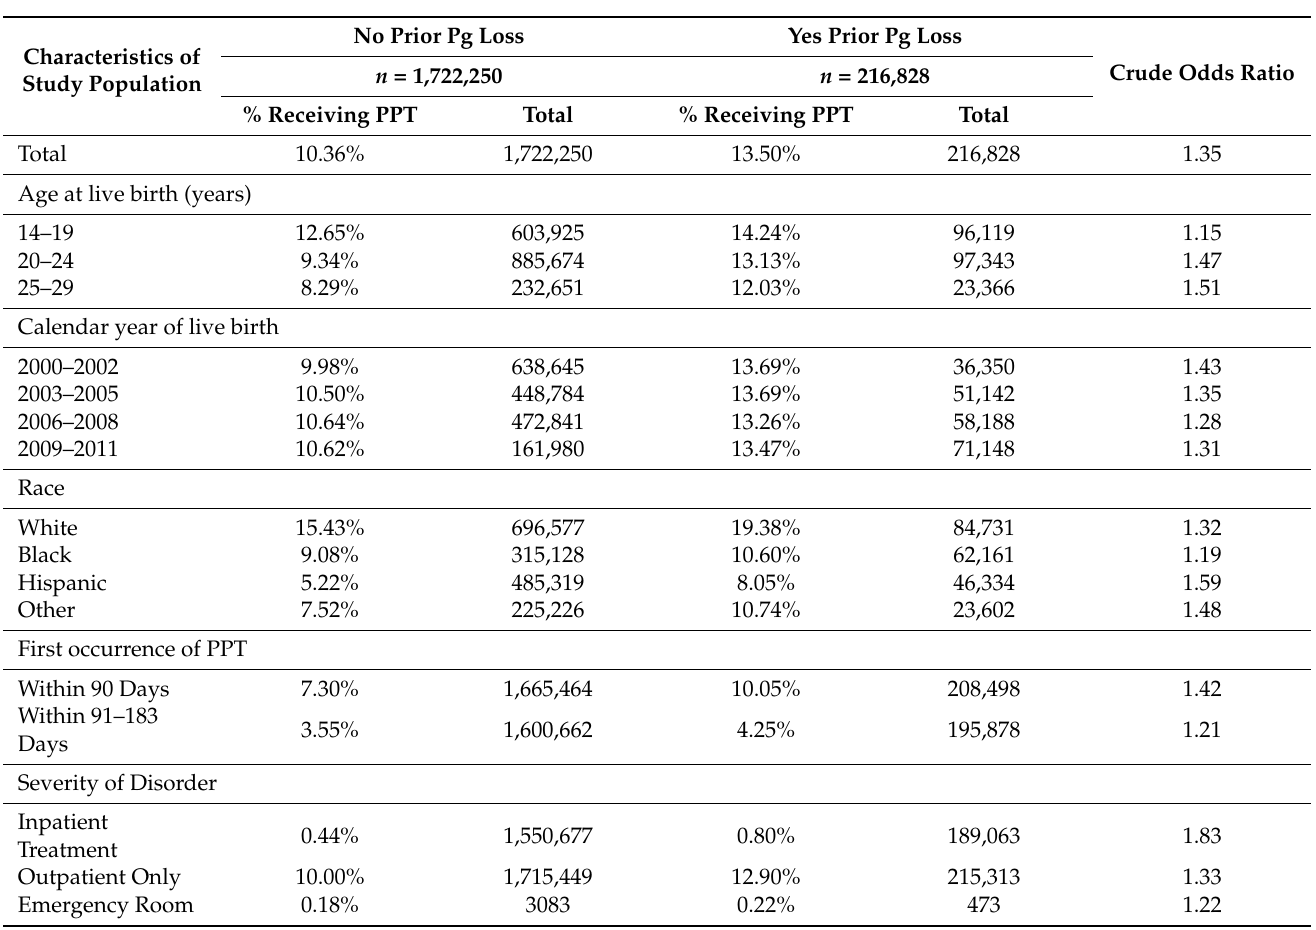
Table 1. Total of all women by subgroup with percentages of total receiving postpartum psychiatric treatment (PPT) rates relative to first pregnancy (Pg) outcome, population differences, timing, and type of treatment. Characteristics